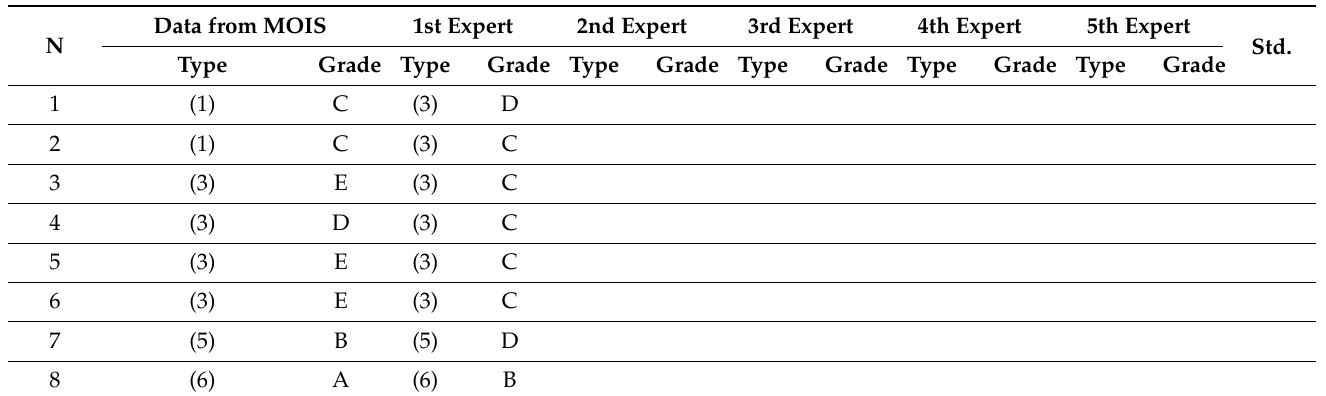
Table 2. Existing evaluation results of GGSJs from MOIS data and field evaluation results by experts. Data from MOIS 1st Expert 2nd Expert 3rd Expert 4th Expert 5th Expert N